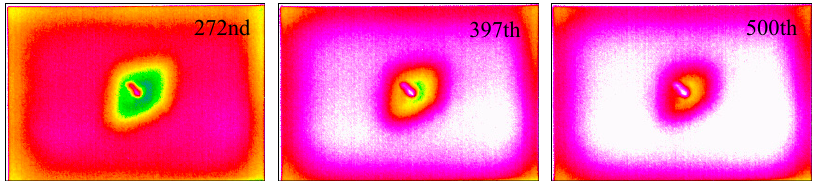
Figure 30. Delamination defect detected by long-pulse thermography.